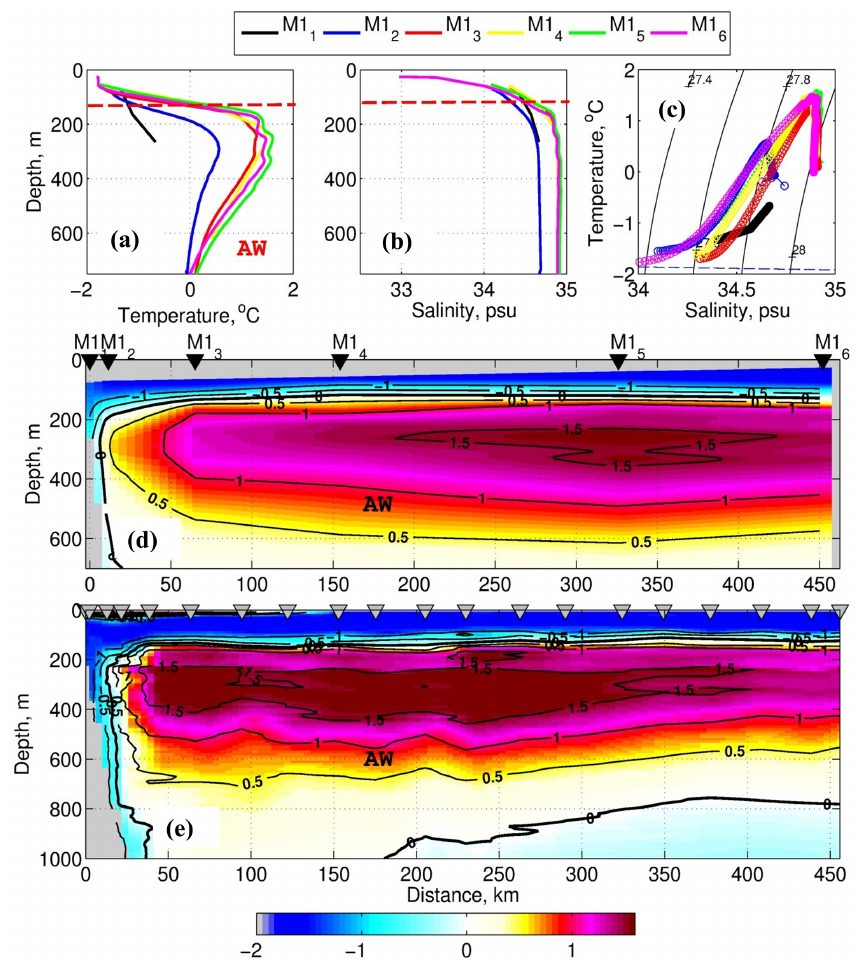
Figure 3. The 2013–2015 mean (a) temperature ( T ) and (b) salinity ( S ) profiles and (c) T − S diagrams from the mooring array deployed at the Laptev Sea slope. Red dashed lines show the position of the AW upper boundary. Mean temperature distribution along the 125 ◦ E section from (d) the 2013–2015 mooring observations and (e) 2013 summer CTD section. Black thick lines in (d) and (e) show the boundaries of the AW layer. Gray triangles in (e) show the positions of CTD stations in